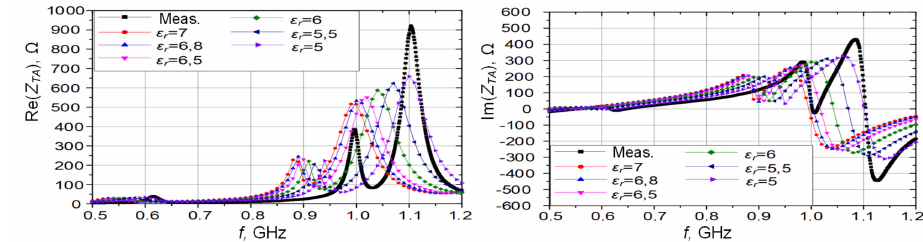
Figure 10. TCO impact on impedance of RFID antenna made on FR408 and placed on Stopray Vision-50 glass.